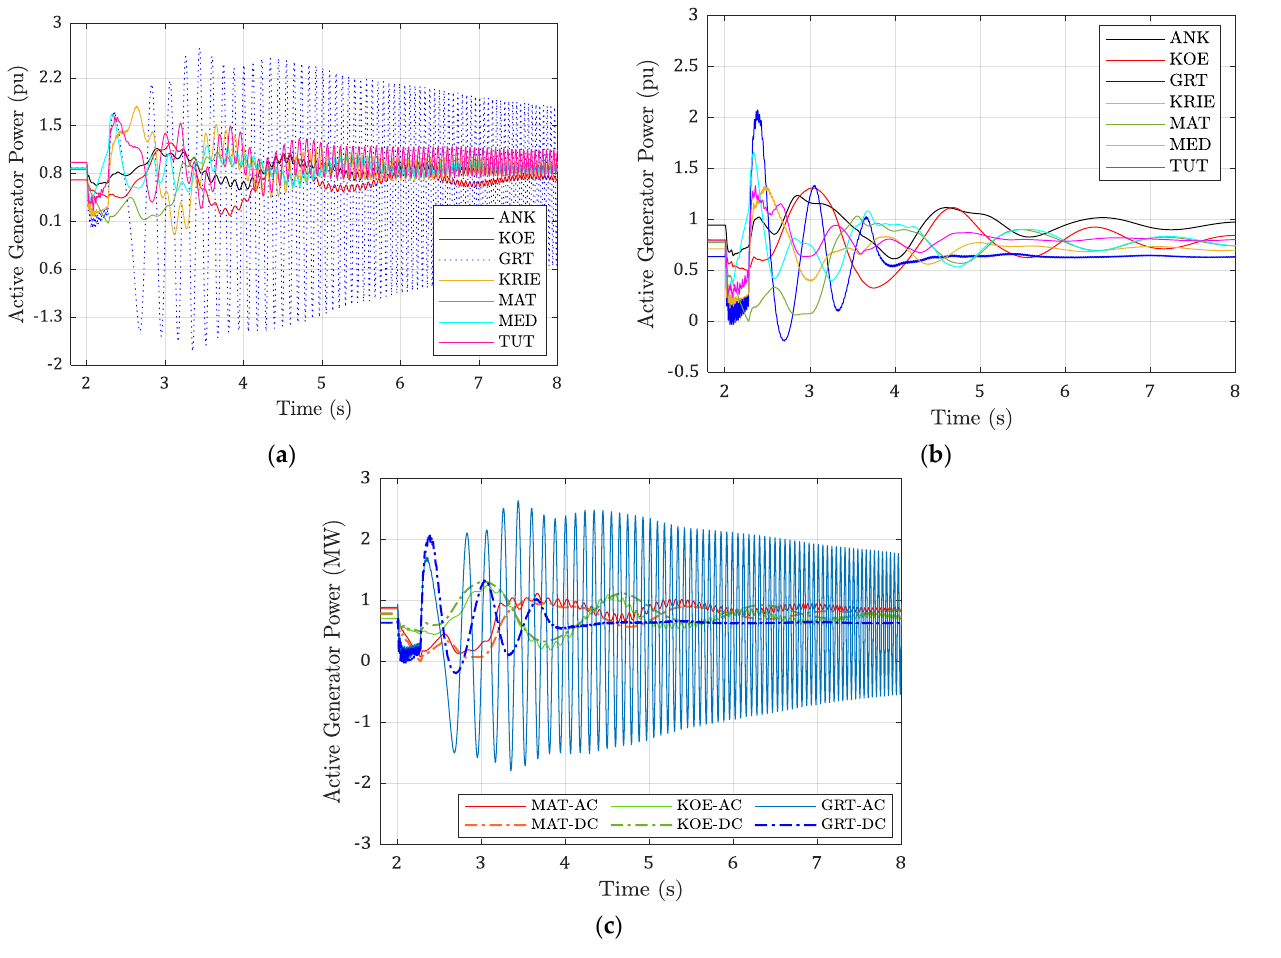
Figure 10. Active power for the synchronous generator ( a ) without the MTDC link, ( b ) with the MTDC link and a ( c ) comparative plot of the active power of three generators in each grid.